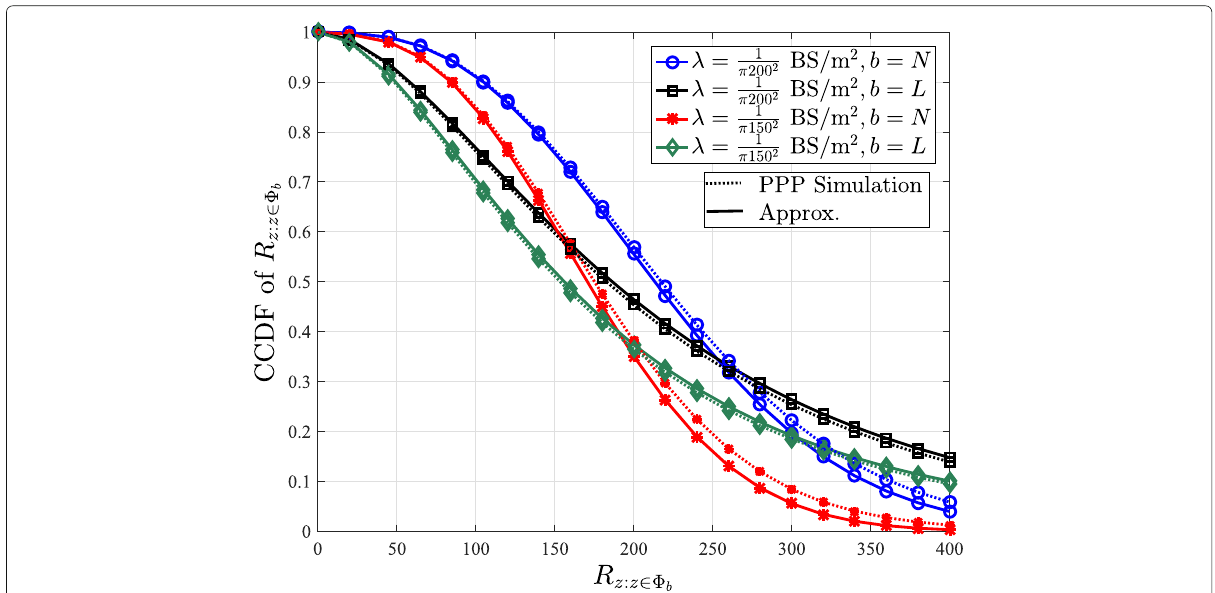
Fig. 2 A comparison of the CCDFs of R z : z ∈ (cid:3)